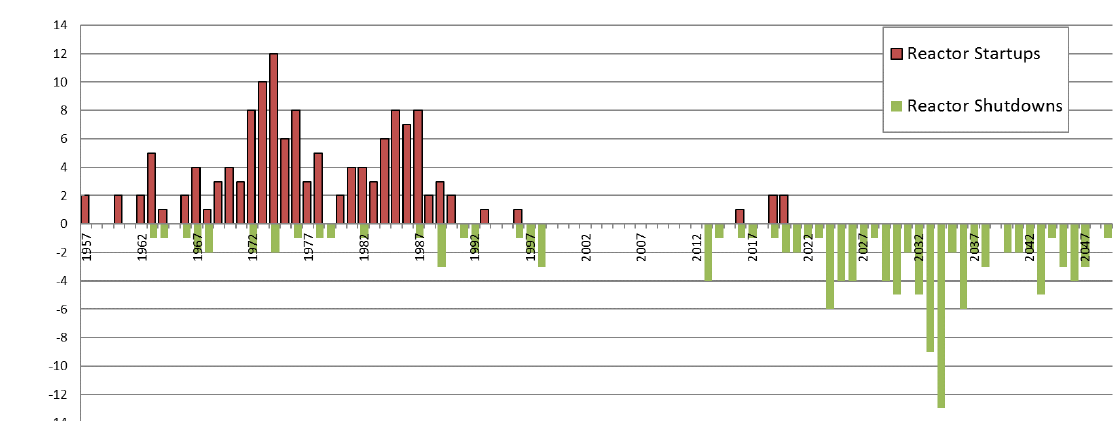
Figure 2. U.S. nuclear power reactor grid connections and permanent shut-downs (1957–2050). Source: own representation based on IAEA (IAEA Power Reactor Information System: the database on Nuclear Power Reactors. Accessed via the internet on 31.01.2018 at https://www.iaea.org/ PRIS/home.aspx; NRC. List of power reactor units. Accessed via the internet on 31.01.2018 at https://www.nrc.gov/reactors/operating/list-power-reactor-units.html; Schneider, M.; Froggatt, A.; Hazemann, J.; Fairlie, I.; Katsuta, T.; Maltini, F.; Ramana, M.V. World Nuclear Industry Status Report 2016, 2016. Accessed via the internet on 27.07.2016 at http://www.world-nuclearreport.org/IMG/pdf/ 20160713MSC-WNISR2016V2-HR.pdf) [2,20], and own